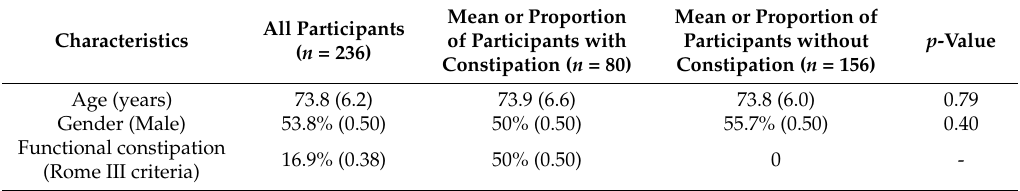
Table 1. Mean ( ± standard deviation ( ± SD)) or proportion ( ± SD) of age, gender and functional constipation for all participants and these values alongside p -values for comparisons between participants with and without constipation.